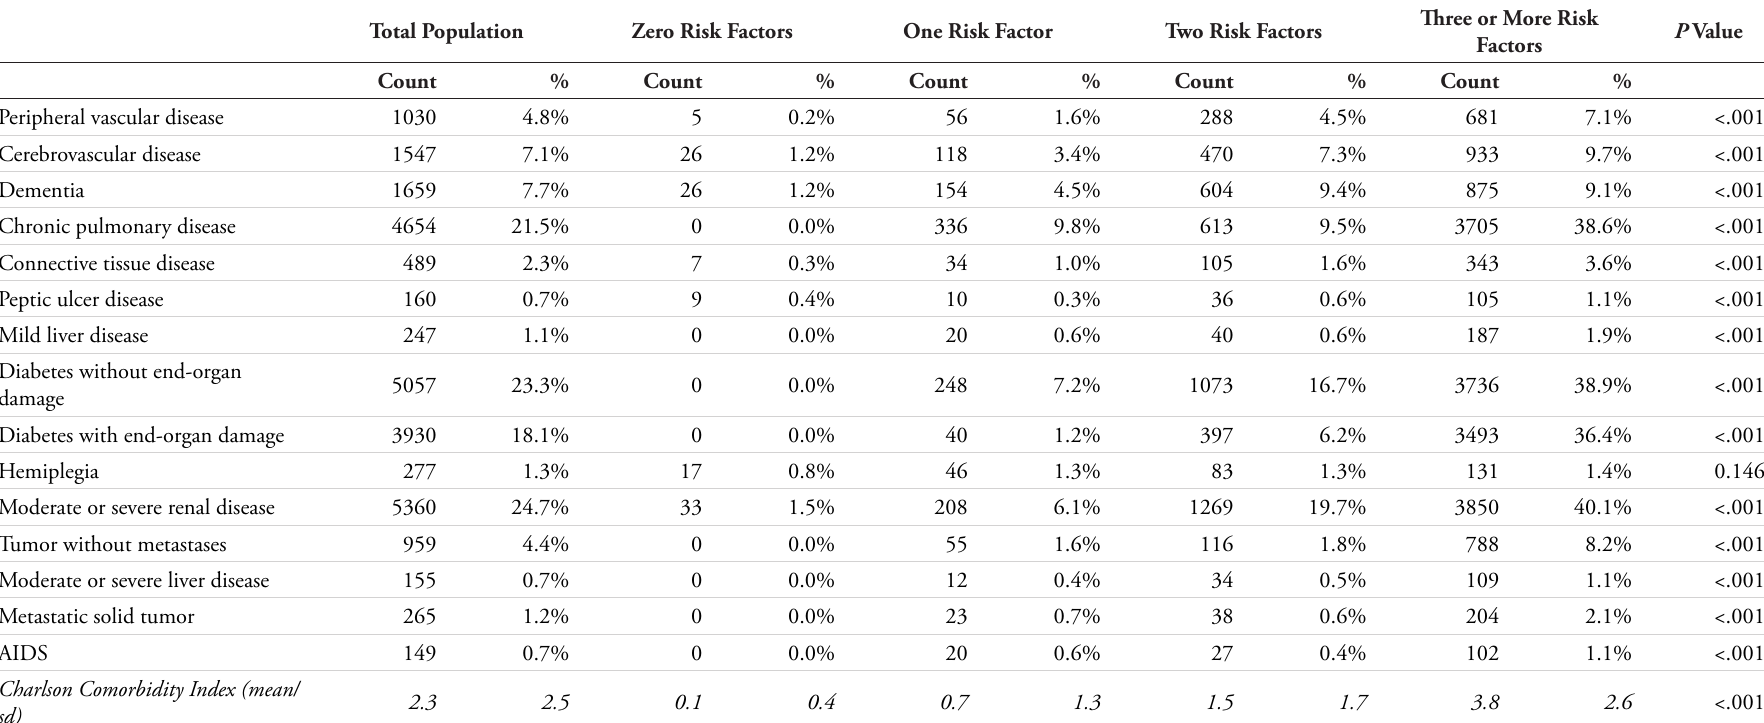
Table 1. COVID-19 Patient Characteristics by Number of Risk Factors Total Population Zero Risk Factors One Risk Factor Two Risk Factors